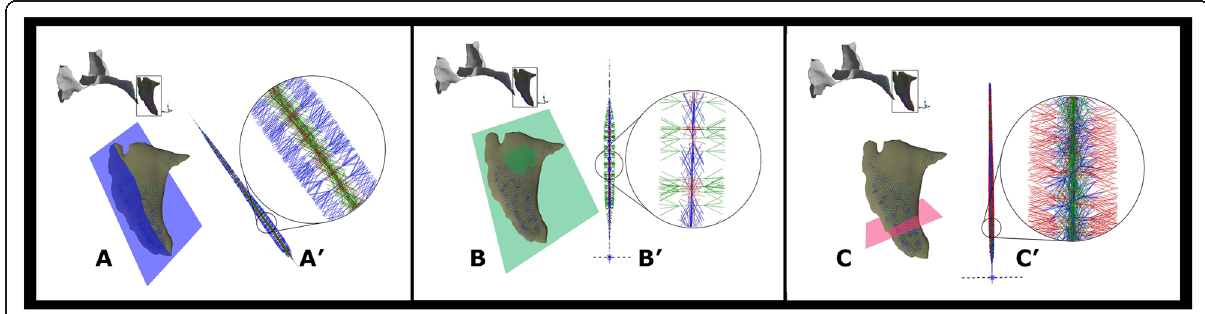
Fig. 4 Principal Stress vector ’ s section. a MinPS — section position. a ′ MinPS — enlarged view of the MinPS vectors ’ directions. b MidPS — section position. b ′ MidPS — enlarged view of the MidPS vectors ’ directions. c MaxPS — section position. c ′ MaxPS — enlarged view of the MaxPS vectors ’ directions